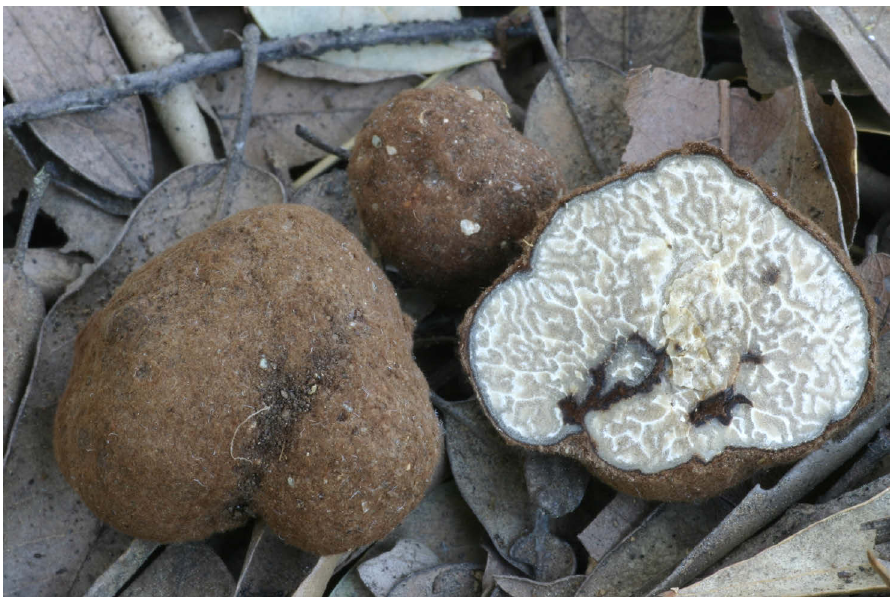
Fig. 3. Tuber panniferum with its chestnut-brown and hairy exoperidium − secure base for identification in the field.